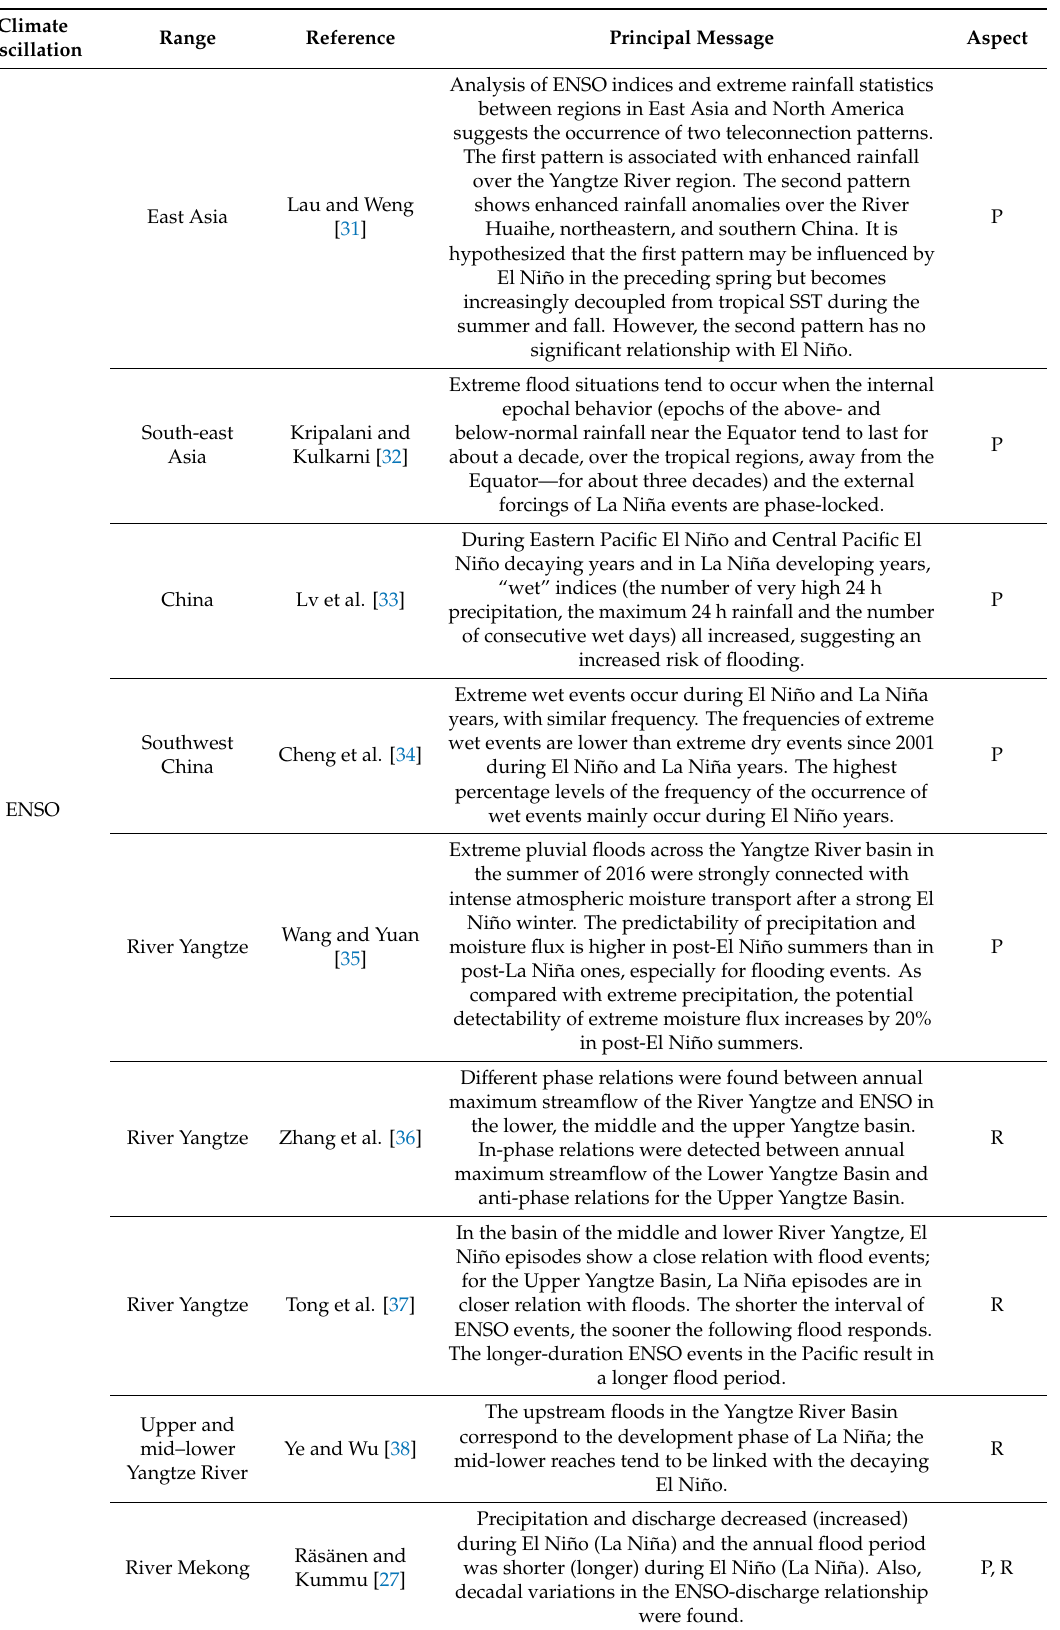
Table 3. Review of links between climate oscillations and floods for Asia, as reported in literature. Aspects of reference in the rightmost column—as in Table